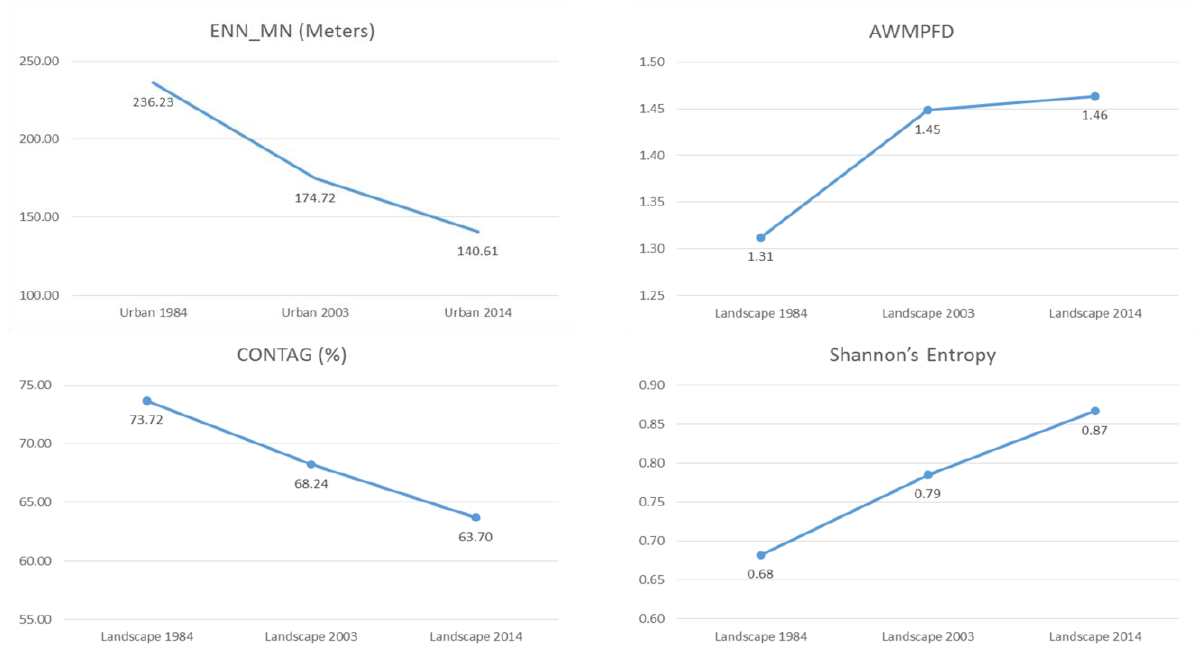
Figure 5. Temporal urban growth signatures of spatial metrics (Class Area, Number of Patches, Edge Density, Largest Patch Index, Euclidian Mean Nearest Neighbor Distance, Area Weighted Mean Patch Fractal Dimension, Contagion, and Shannon’s Entropy).